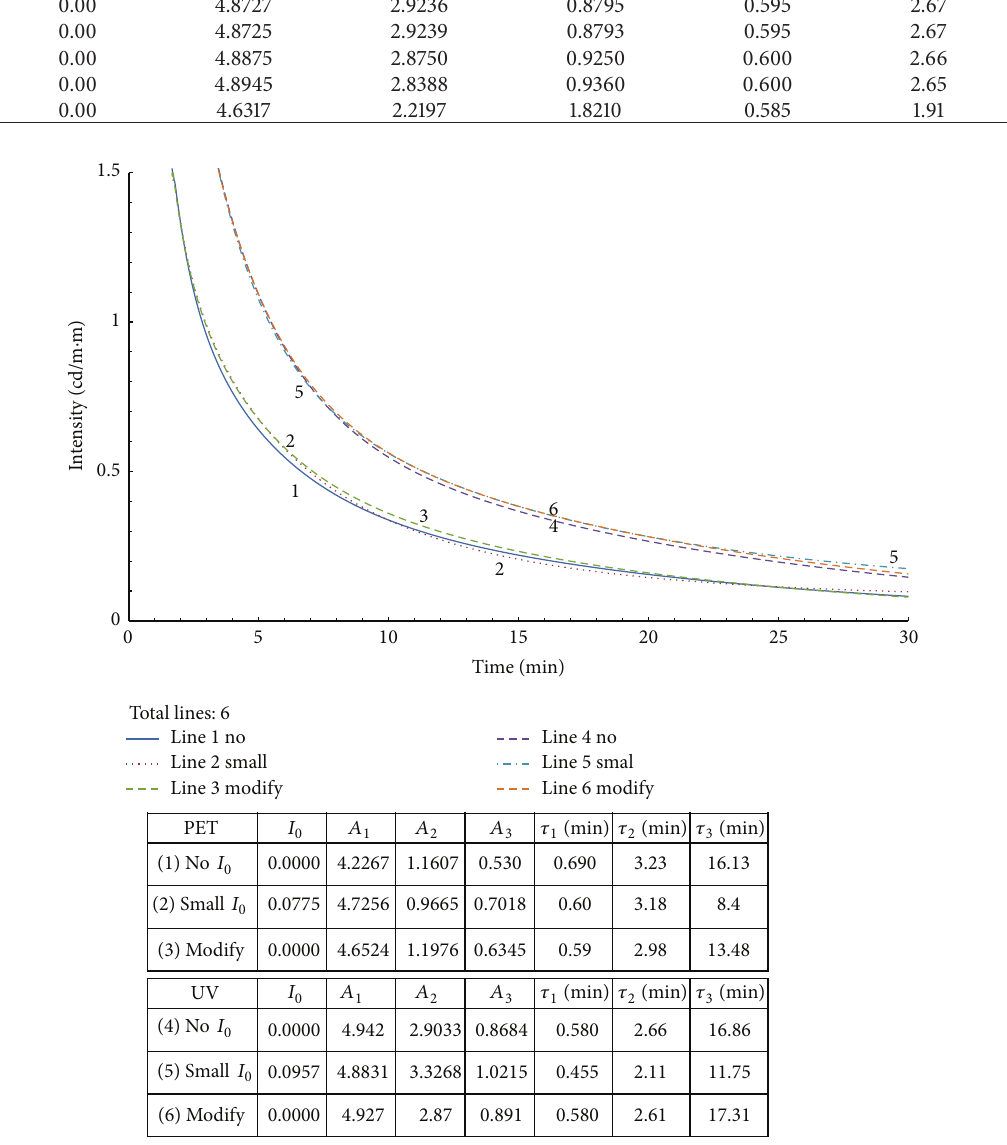
Figure 2: Modified curves with small 𝑅 values from Figure